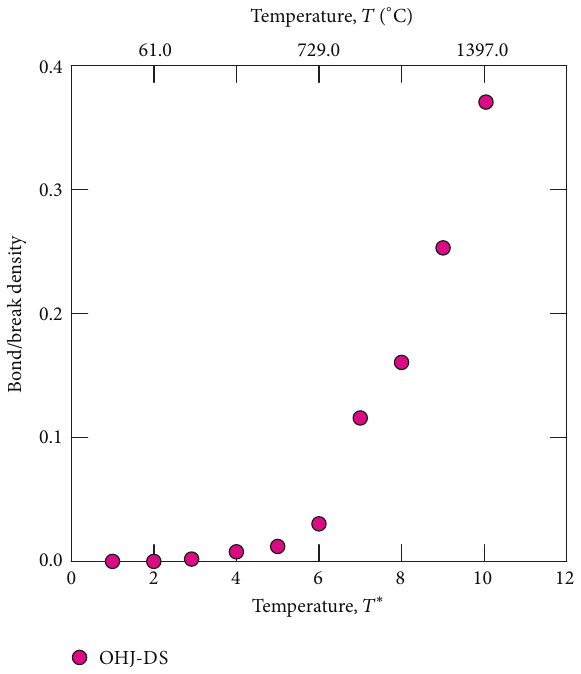
Figure18:Effectoftemperaturesonthebond/breakdensityofOHJ- DS on DLC